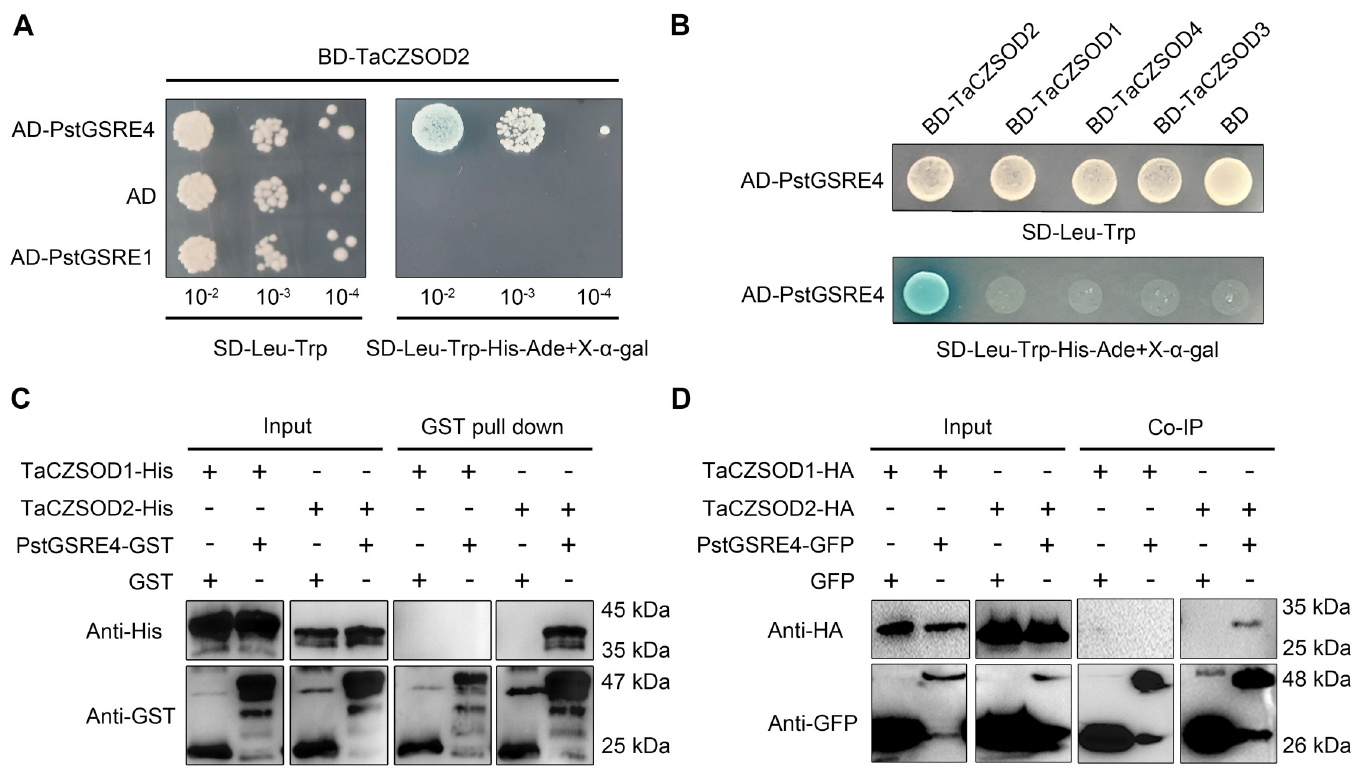
Fig 3. PstGSRE4 specifically interacts with wheat TaCZSOD2 in vitro and in vivo . (A) PstGSRE4 interacts with TaCZSOD2 in yeast. Only the yeast co-expressing PstGSRE4 and TaCZSOD2 grew on the medium SD-Trp-Leu-His-Ade and yielded X- α -gal activity. Co-expressing PstGSRE1 and TaCZSOD2 cannot grow on the medium SD-Trp-Leu-His-Ade. (B) PstGSRE4 specifically interacts with TaCZSOD2 in yeast. Only the yeast co-expressing PstGSRE4 and TaCZSOD2 grew on the medium SD-Trp-Leu-His-Ade and yielded X- α -gal activity. Co-expressing PstGSRE4 and TaCZSOD1, TaCZSOD3 or TaCZSOD4 cannot grow on the medium SD-Trp- Leu-His-Ade. (C) PstGSRE4 interacts with TaCZSOD2 in vitro . A GST pull-down assay was used to detect the interaction between PstGSRE4-GST and TaCZSOD2-His. TaCZSOD2-His and PstGSRE4-GST were detected with anti-His or anti-GST antibodies, respectively. TaCZSOD1-His was used as negative control. (D) PstGSRE4 interacts with TaCZSOD2 in vivo . Co-immunoprecipitation (IP) was performed on extracts of N . benthamiana leaves expressing both PstGSRE4-GFP and TaCZSOD2-HA. GFP was detected by western blot with anti-GFP antibodies. HA was detected by western blot with anti-HA antibodies. The TaCZSOD1-HA was used as negative